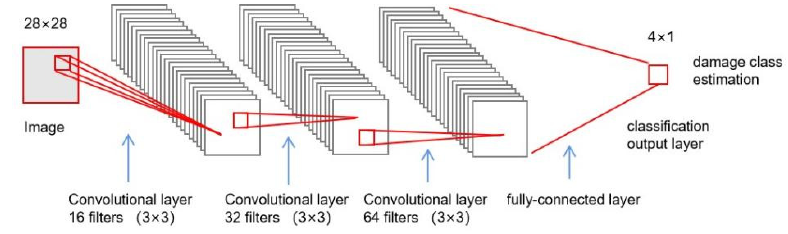
Figure 11. CNN structural model.